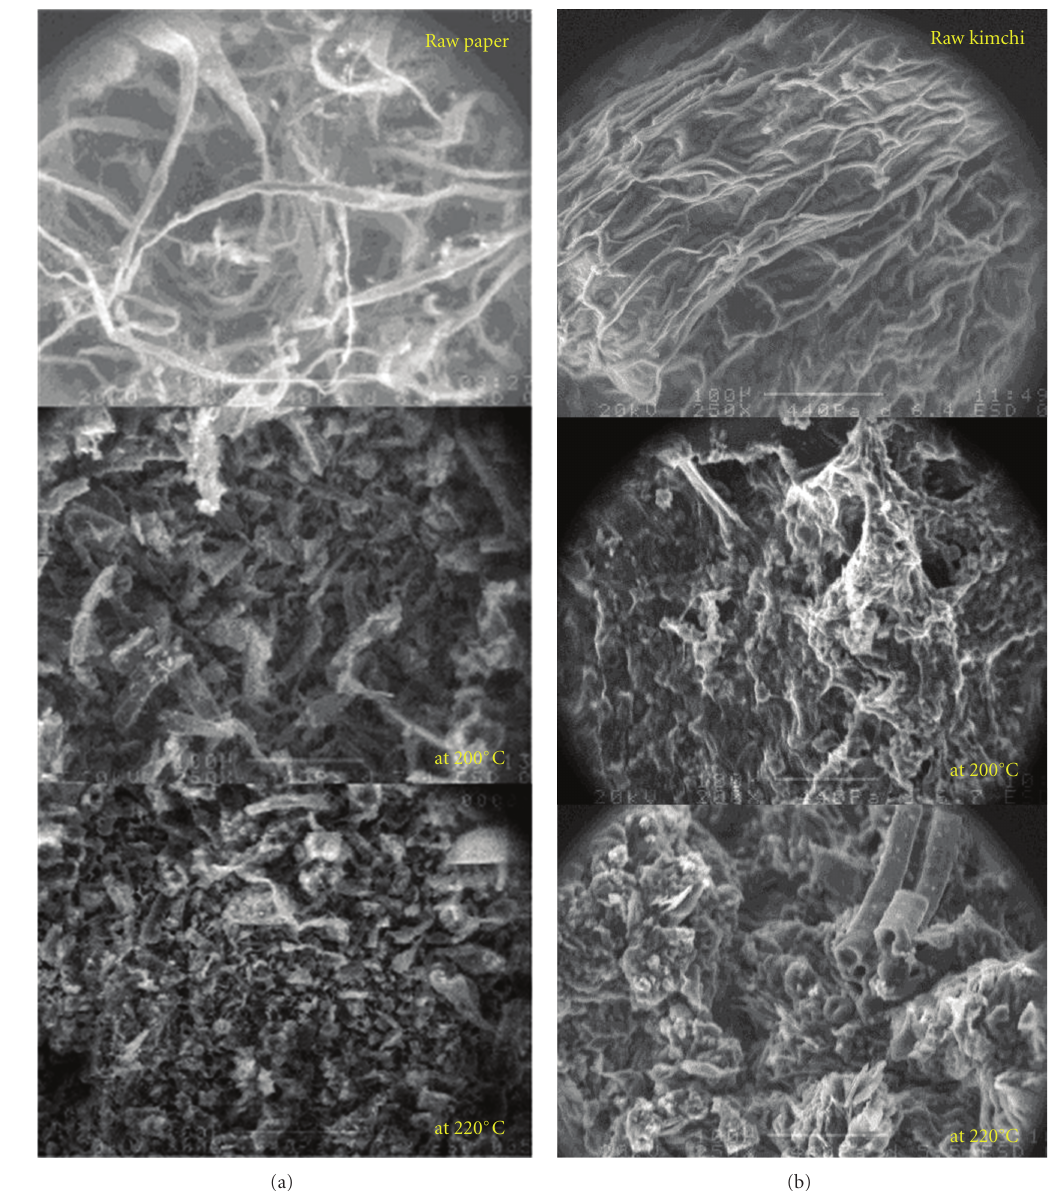
Figure 6: SEM microphotographs of the raw materials and their hydrothermal products; (a) paper and (b)